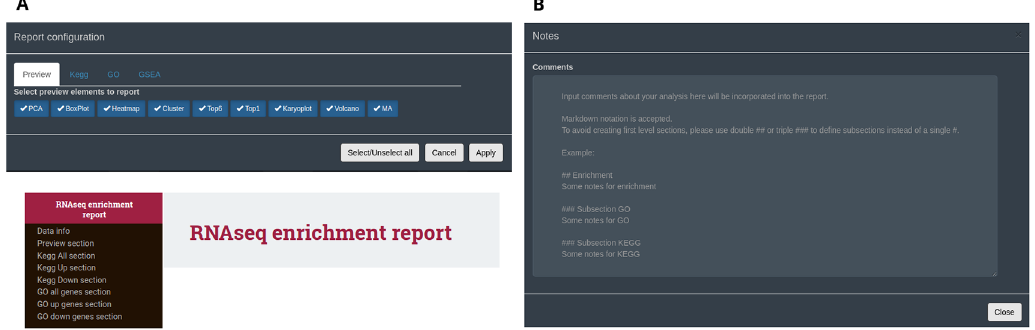
Figure 10. Interactivefinal DEVEA report functionalities and features. A:Configuring box and final HTMLreport. B: Notes transferable to the